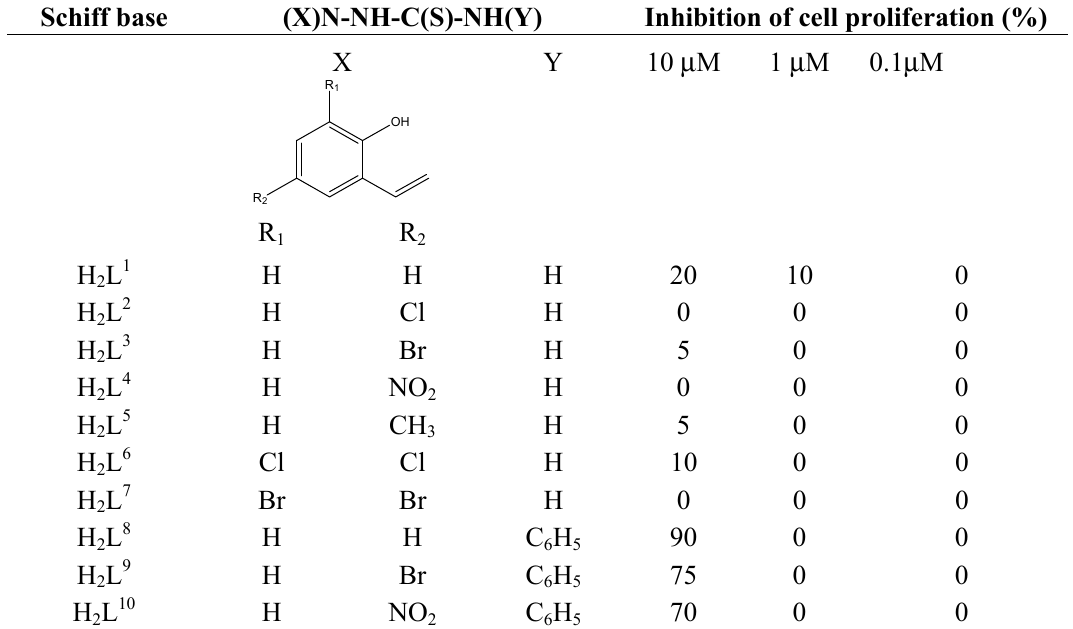
Table 3. Schiff bases H (HL-60) cells at three